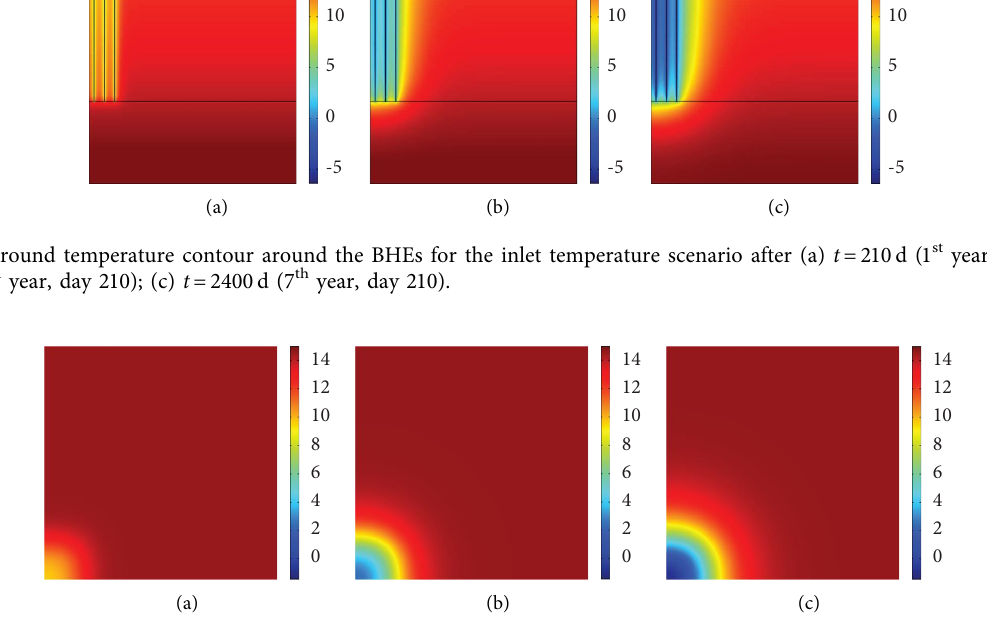
Figure 11: Ground temperature during the recovering season: (a) t � 455 d (2 nd year, day 90); (b) t � 1550d (5 th year, day 90); (c) t � 2645d (8 th year, day